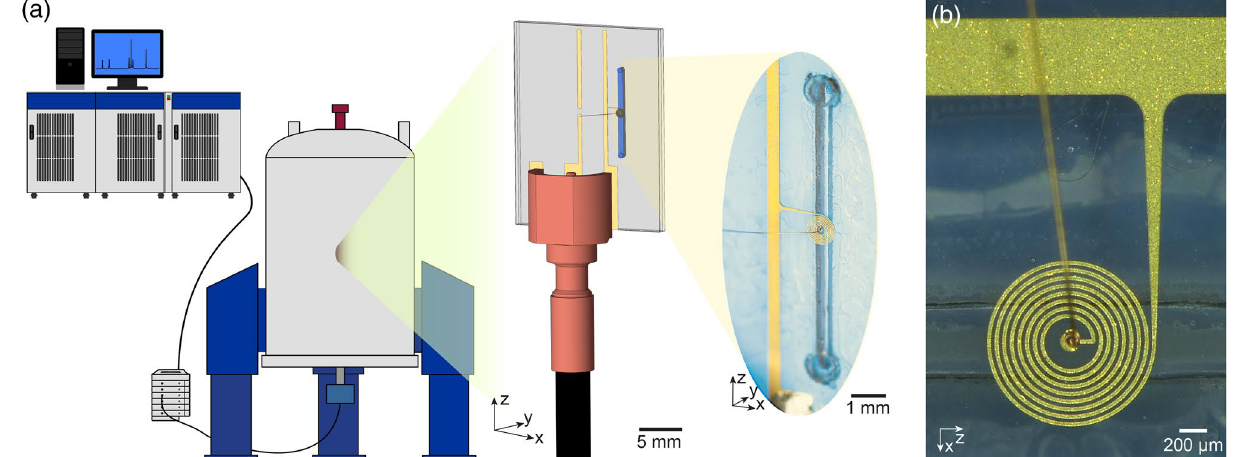
Figure 1. ( a ) NMR experiment setup consisting of a vertical-bore superconductive magnet together with the probe, LNA block, and electronic racks for signal processing. The detector, being mounted on the NMR probe is directly connected to the LNA block using a coaxial cable. The sample is loaded in the microfluidic channel of the detector. ( b ) The broadband coil, wirebond, and the microfludic channel